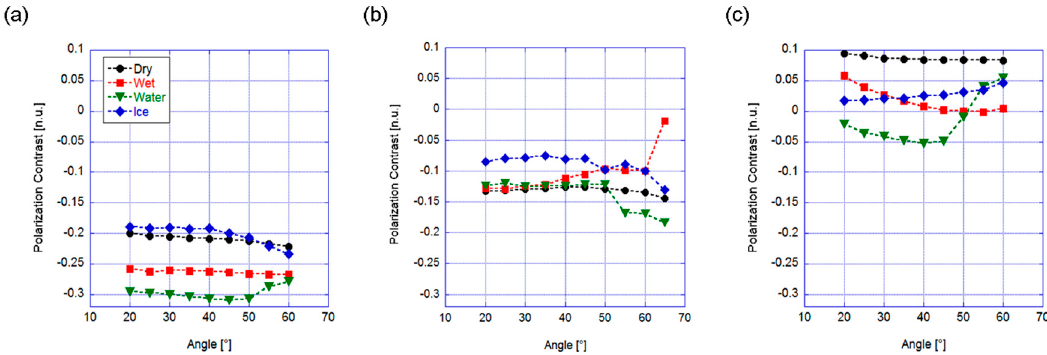
Figure 4. Backscattering configuration. Polarization contrast versus incidence angle for ( a ) unpolarized, ( b ) horizontally and ( c ) vertically polarized incident light.